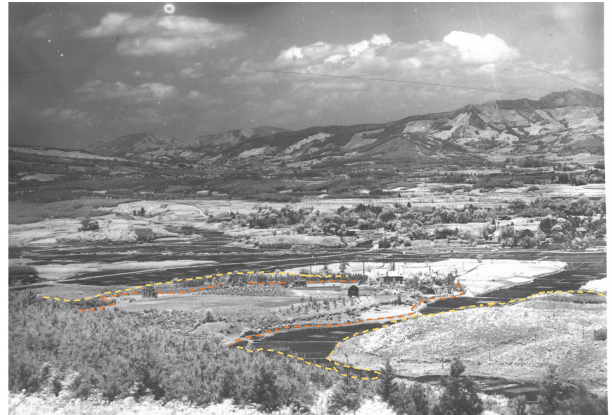
Figure 3. A view of Kakioka Magnetic Observatory from Fuji- yama in 1933. An orange dotted line indicates the property of the observatory, and a yellow dotted line indicates the property of Tokyo Imperial University (after a photo supplied by Kakioka Mag- netic Observatory).